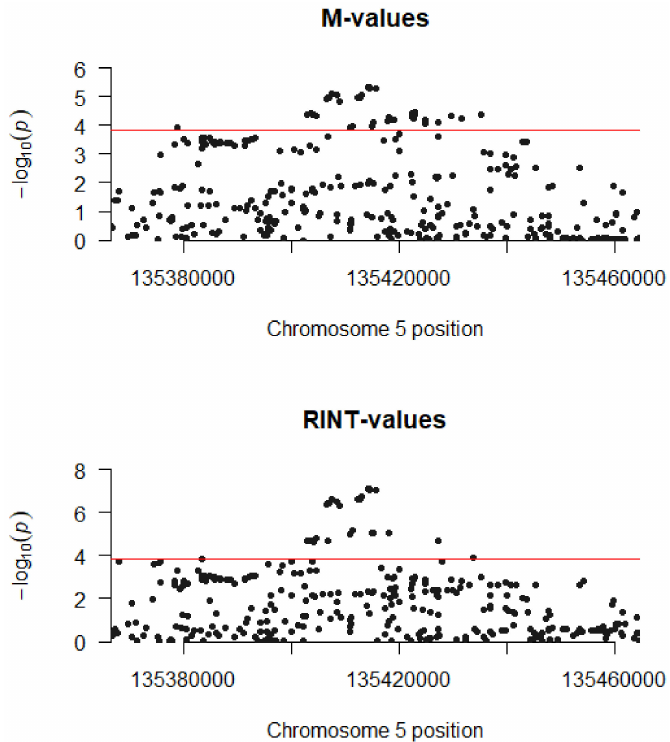
Figure 3. Manhattan plot for 334 genetic variants within 50 kb of cg06536614. The red line shows the Bonferroni threshold used to declare cis- mQTLs ( p = 1.5 × 10 − 4 ); for the M-value analysis, the 46 significant associations are presented in Table 2. All variant names, positions, and quantitative results are shown in Supplementary Table S3 and